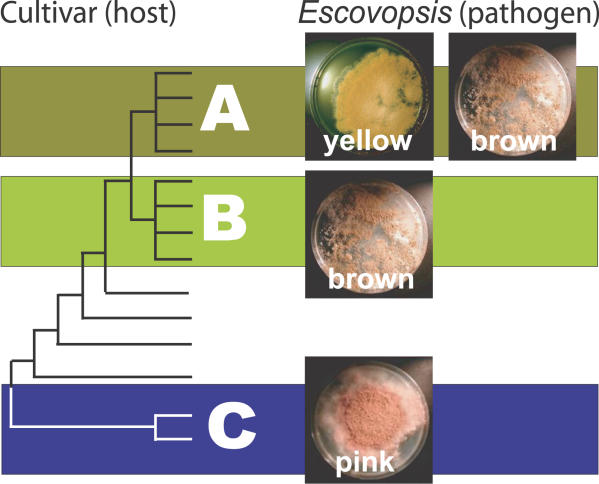
Schematic Diagram of the
Escovopsis–Cultivar System
Fungus-growing ants in the genus
Apterostigma cultivate fungi in three distinct groups. Cultivars in clade C (referred to in the text as cultivar C) are lepiotaceous fungi distantly related to the pterulaceous cultivars in clades A and B. Free-living, nonsymbiotic fungi fall between clade C and the other cultivars. Each cultivar clade is attacked by specific
Escovopsis types, here identified according to spore color. Note that the same brown
Escovopsis attacks both cultivars A and B. Schematic cultivar phylogeny based on [
33].